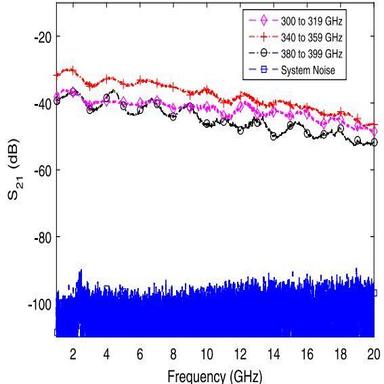
Measurement equipment losses.